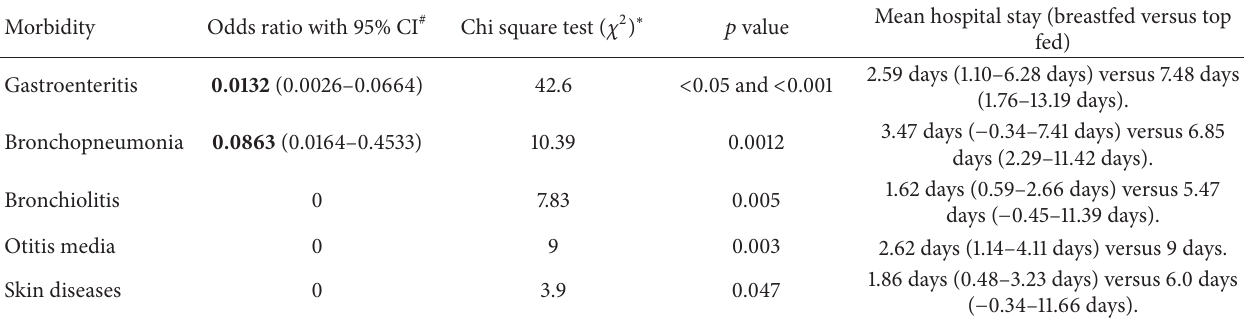
Table 3: Statistical analysis: hospital stay versus feeding pattern.